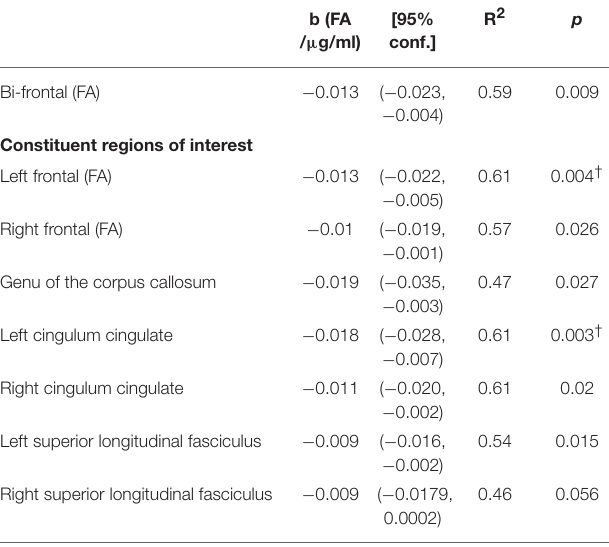
TABLE 3 | Bifrontal DTI measures correlate with plasma LBP in GRN mutation